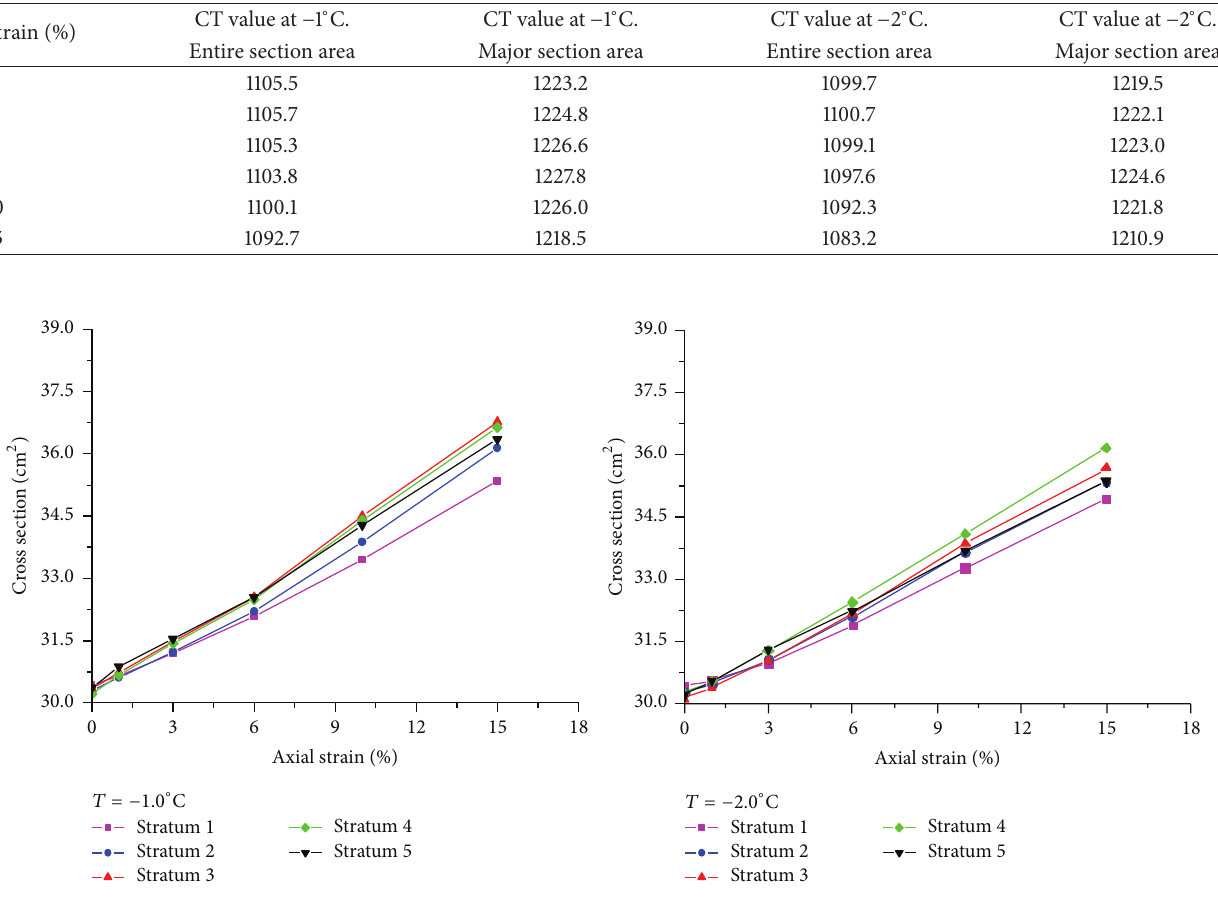
Figure 5: Cross section propagation of warm and ice-rich frozen silt.